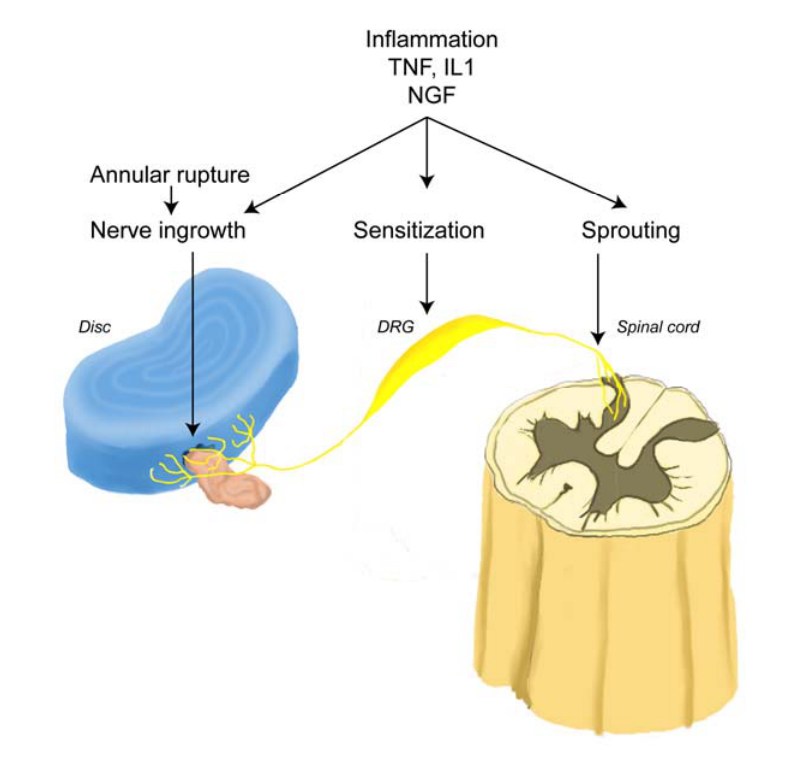
Figure 5. Schematic representation of a mechanism for LBP. An annular rupture leads to extrusion of the nucleus pulposus (pink) outside annulus fibrosus (blue), which induces nerve injury and nerve in-growth into the disc (yellow). Under inflammatory conditions which may occur following surgery, nerve growth factor (NGF) is induced in the disc and acts on the nerve root (DRG) through the peripheral terminals in the disc. Disc-innervating neurons have a high sensitivity to NGF. NGF may promote nerve in-growth into the disc, sensitize DRG neurons, and cause neuronal sprouting into the dorsal horn (adapted from Takahashi et al.